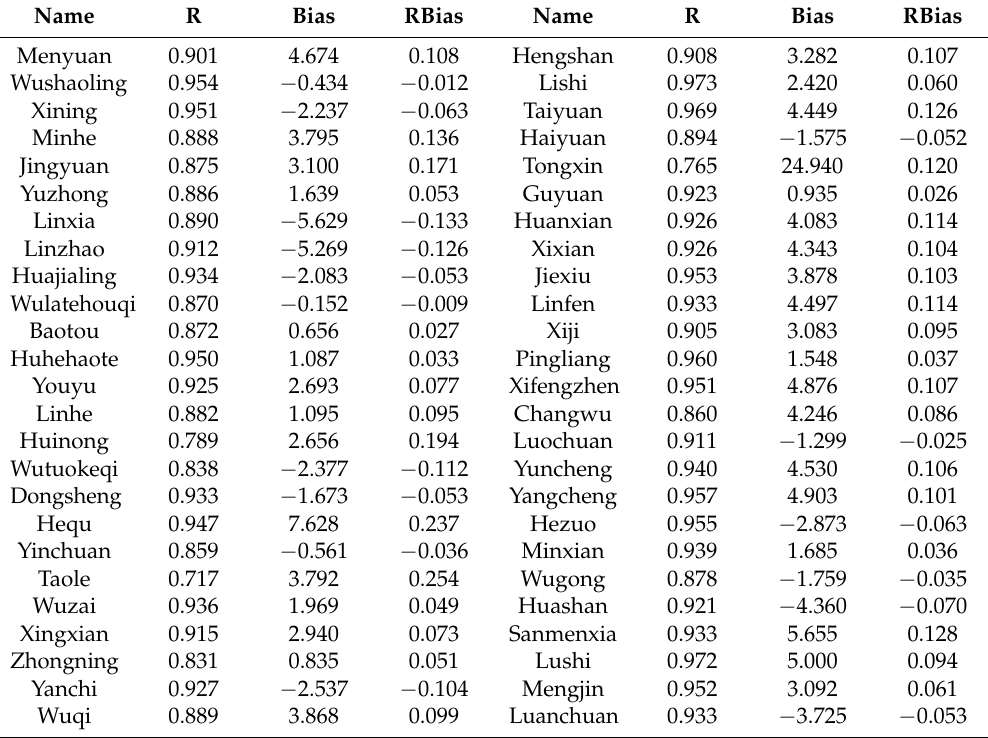
Table 3. The comparison results of the observed and TRMM values of monthly precipitation from 1998 to 2014 in the 50 meteorological